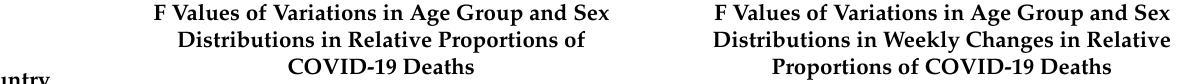
Table 3. Summary F values for variations among age groups and between the two sexes in relative proportions of COVID-19 deaths and in weekly changes between successive weeks in the relative proportions of COVID-19 deaths in 13 countries. F Values of Variations in Age Group and Sex F Values of Variations in Age Group and Sex Distributions in Weekly Changes in Relative Distributions in Relative Proportions of Proportions of COVID-19 Deaths COVID-19 Deaths Country Number of Number of Age Group Sex Age Group Sex Weeks Data Points